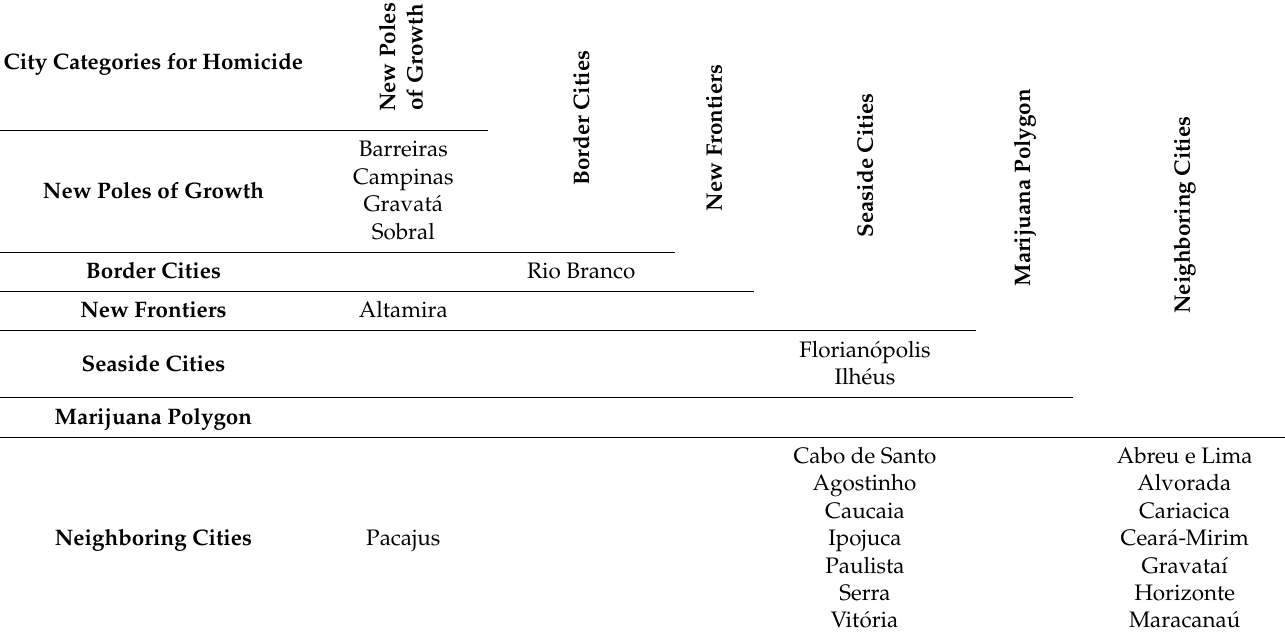
City Categories for